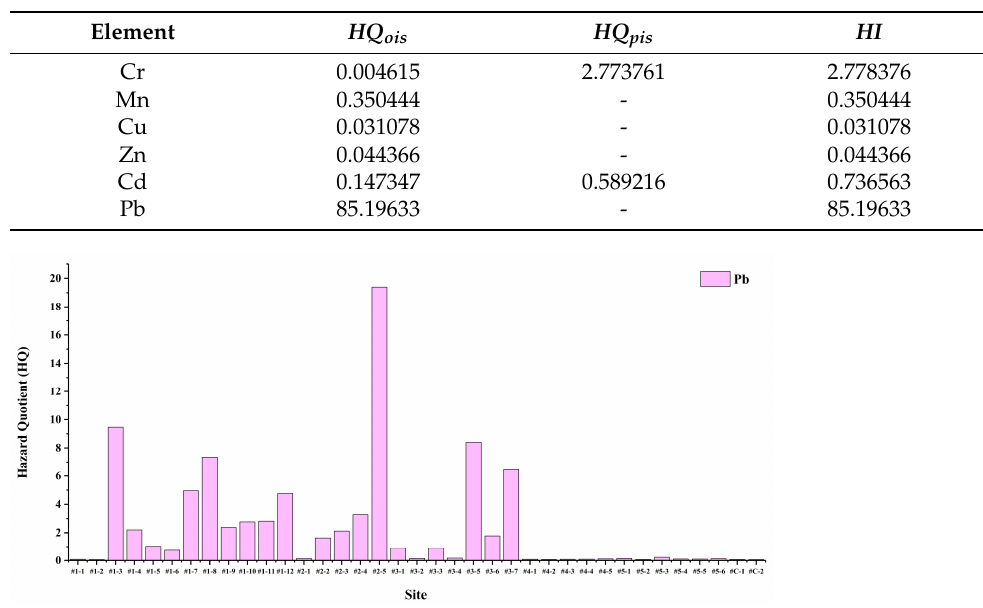
Table 6. HQ results for each HM exposure pathway.